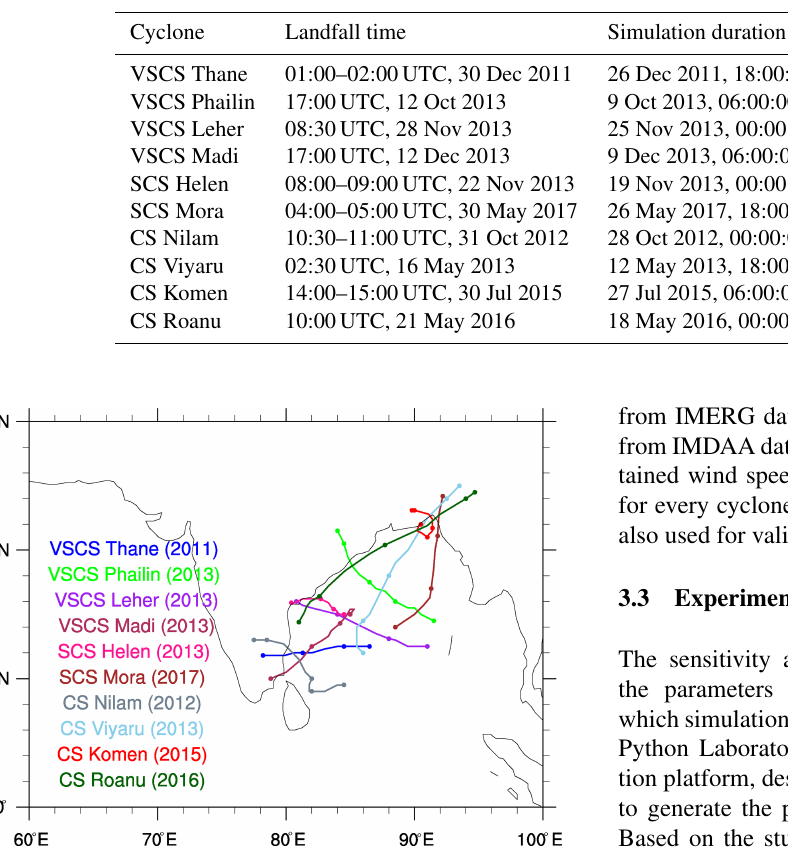
Figure 2. India Meteorological Department (IMD) observed tracks of the selected tropical